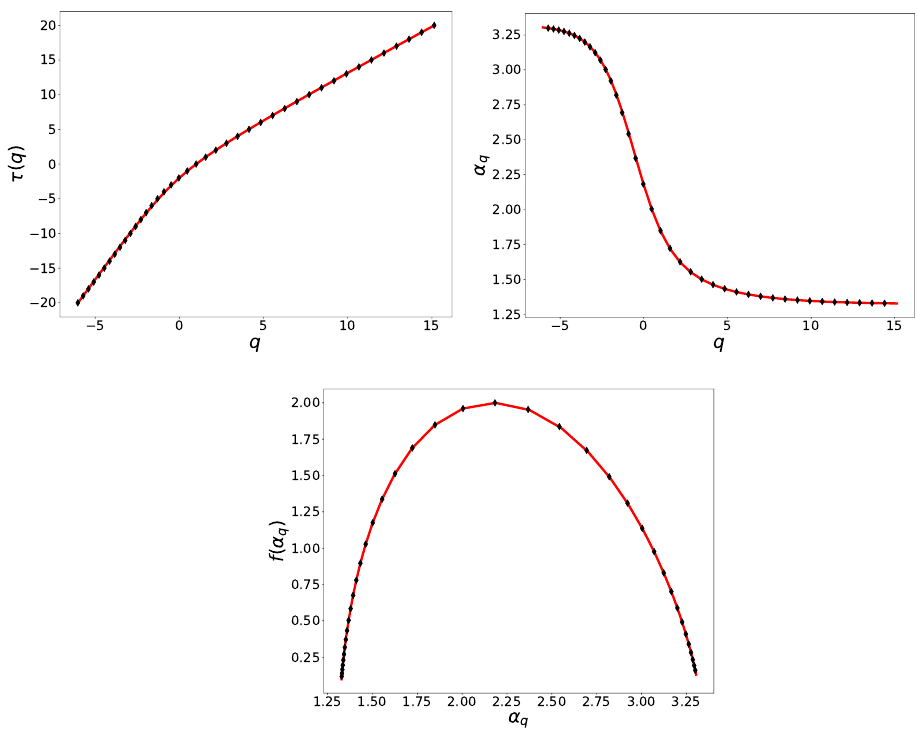
Figure 2. Comparison between the theoretical (solid line) and numerical (diamonds) values of τ q (upper left panel), α q (upper right panel) and f ( alpha q ) (lower